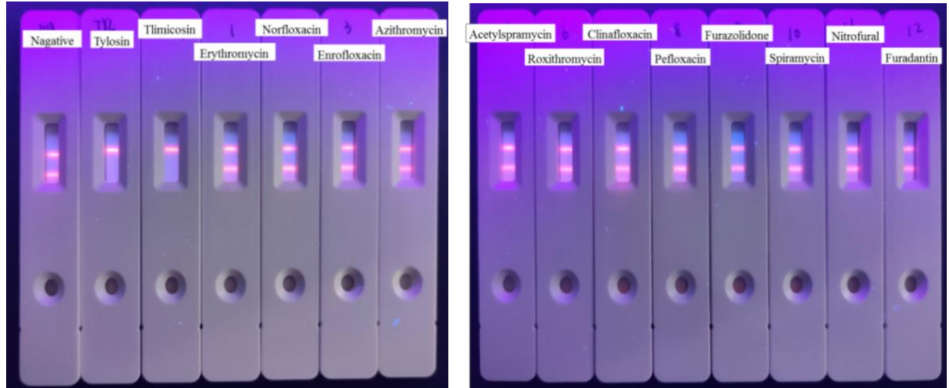
Figure 9. CRs of related or similar compounds in the TRFICA ( n = 3).